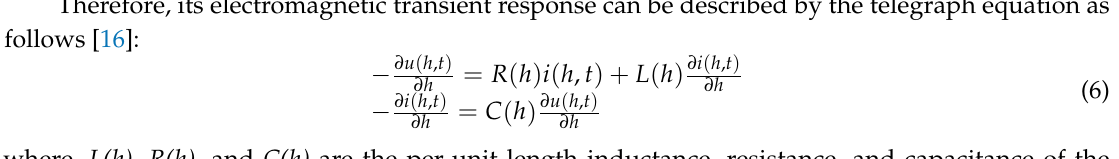
Figure 3. Tower on the DC pole and the equivalent model of the tower. Therefore, its electromagnetic transient response can be described by the telegraph equation as follows [16]: